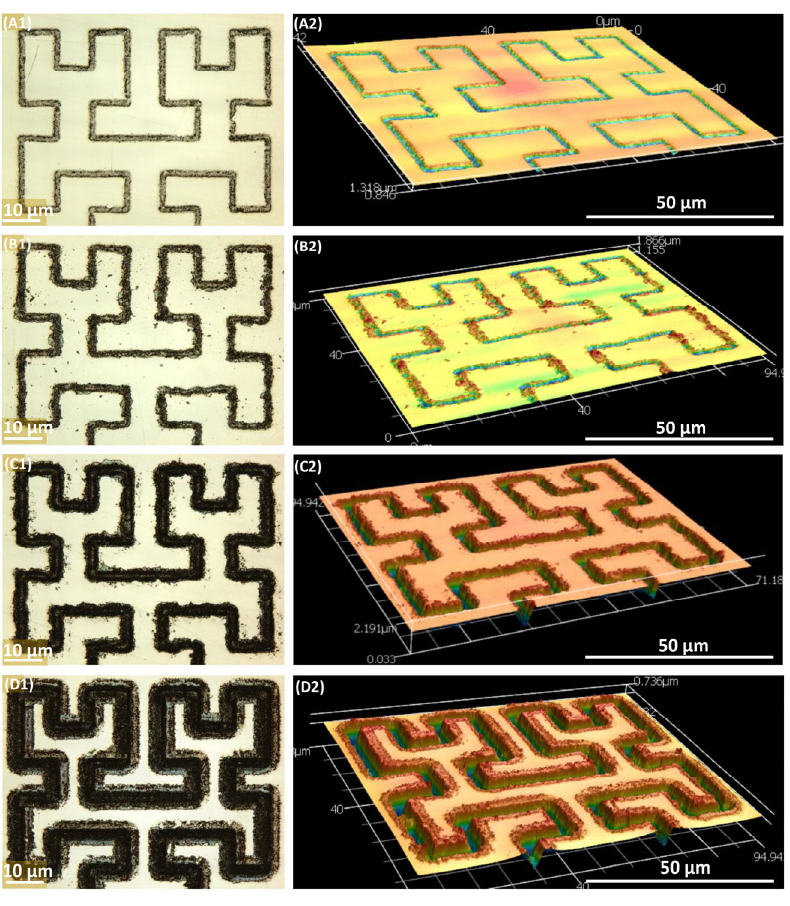
Fig. 2 Effect of different laser powers on the Hilbert curve textures: (A) LP = 5%, (B) LP = 10%, (C) LP = 15%, and (D) LP = 20%.